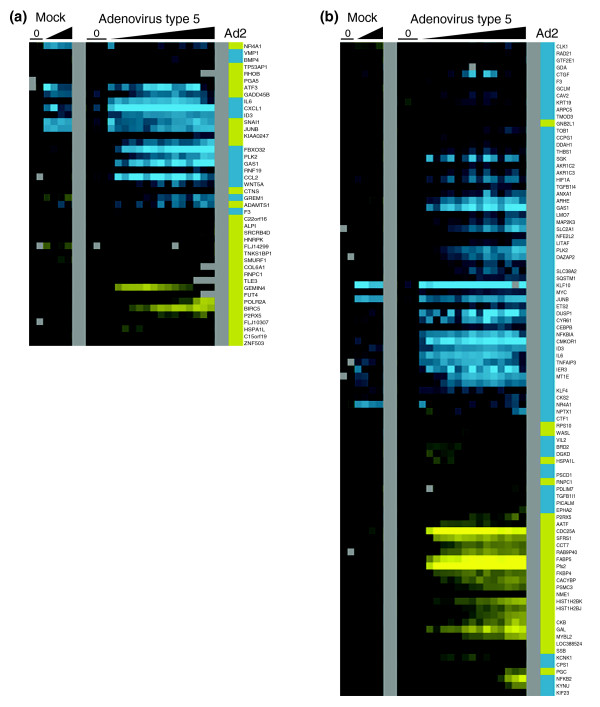
Comparison of adenovirus-induced changes in gene expression in HeLa cells and HFFs. The genes reported to exhibit changes in expression at (a) 6 hours or (b) 10 and 21 hours after infection of HeLa cells by adenovirus type 2 (Ad2) [54,55] were isolated from our dataset and clustered on the basis of their responses to infection of human foreskin fibroblasts (HFFs). The changes observed in HeLa cells are summarized in the columns labeled Ad2, in which yellow and blue represent increased and decreased expression respectively. In panel b, the HeLa response is based on the average of the two time points. Ramps above panels indicate increases in time after infection.